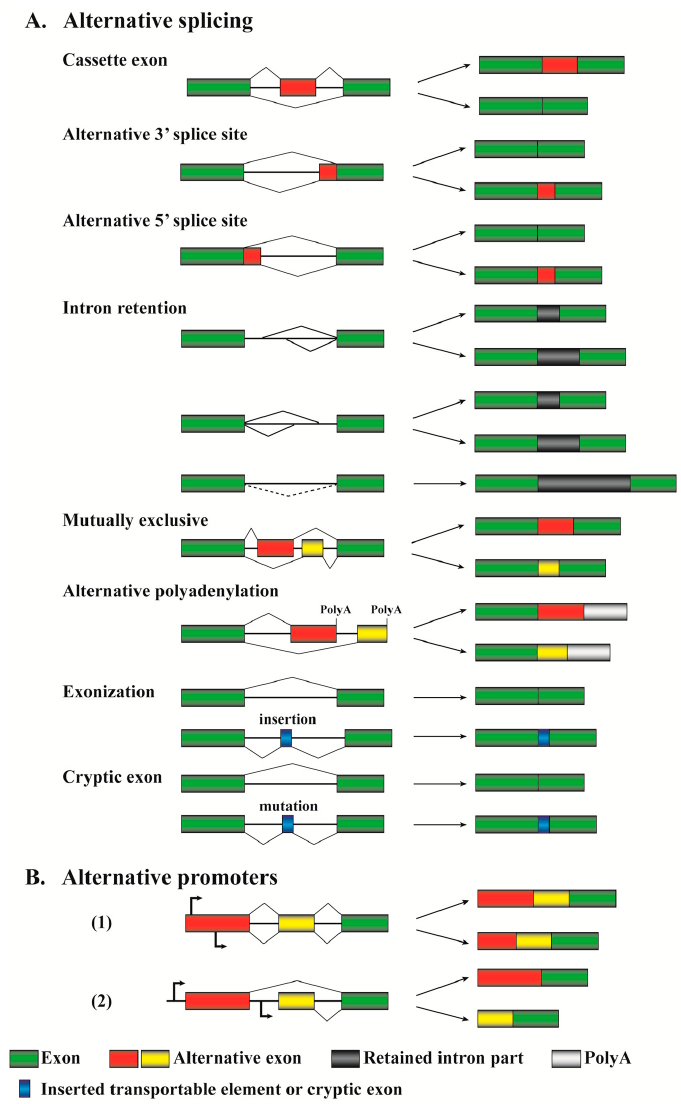
Figure 2. Schematic diagrams of the alternative splicing and alternative promoter patterns. ( A ) Alternative splicing. Exons and final transcripts are illustrated as boxes, while introns are represented by lines. Constitutively expressed exons are depicted in green, and alternatively spliced exons are in red or yellow. Folded lines are used to connect spliced ends. In the intron retention pattern, the intervening intron parts in the final transcripts are indicated by black boxes, while the dotted line represents no alternative splicing. PolyA sequences are depicted by grey boxes. In exonization and cryptic exon mechanisms, new exons (blue box) are generated by transportable element insertion or intronic sequence mutation; ( B ) Alternative promoters. The same representations are used as in “A”. Promoters are indicated by bent arrows. The upper arrows are the promoters for the transcription and pre-mRNA splicing indicated on the top, while the lower arrows indicate the promoters for the transcription and splicing at the bottom.